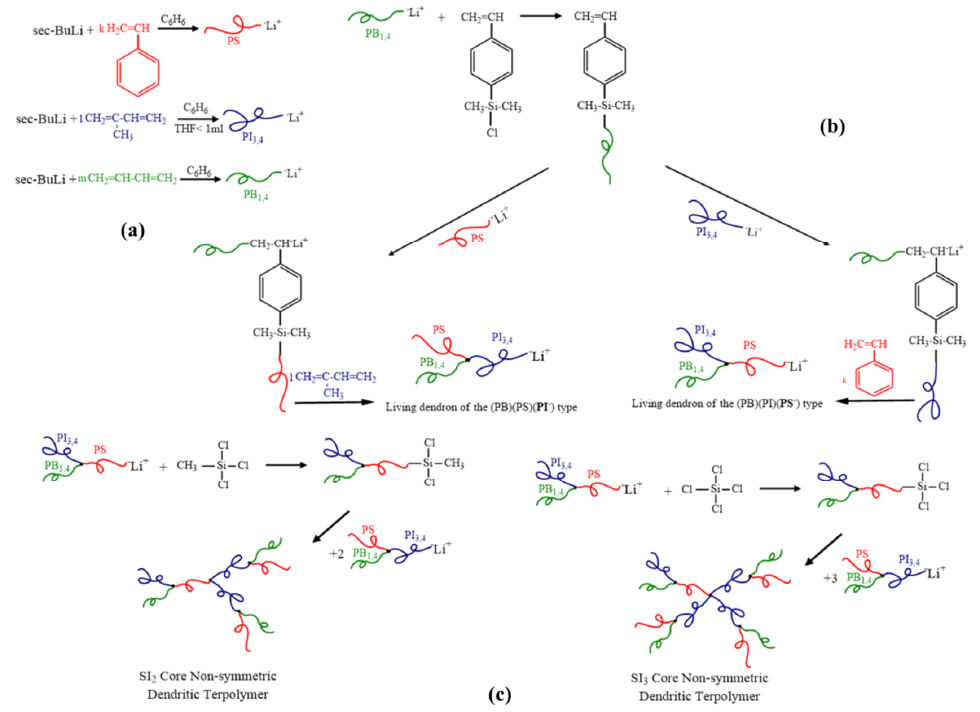
Figure 2. Schematic illustration of: ( a ) the synthetic procedure for the three different PS, PB and PI segments used in the intermediate steps for the synthesis of the two different living dendrons, ( b ) the preparation for the two different living dendrons of the (PB)(PS)( PI − ) and the (PB)(PI)( PS − ) types respectively and ( c ) the coupling reaction for the formation of the [(PB)(PI)(PS c )][(PS)(PB)(PI c )] 2 or SI 2 core type and [(PB)(PI)(PS c )][(PS)(PB)(PI c )] 3 or SI 3 core type non-symmetric dendritic terpolymers.